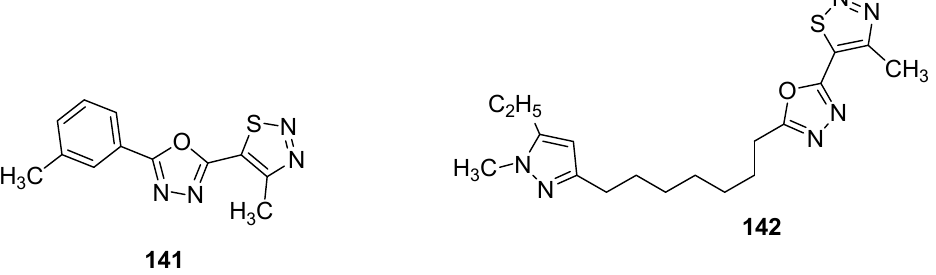
Figure 27. Novel potent 1,2,3-thiadiazole fungicides 141 and 142 .